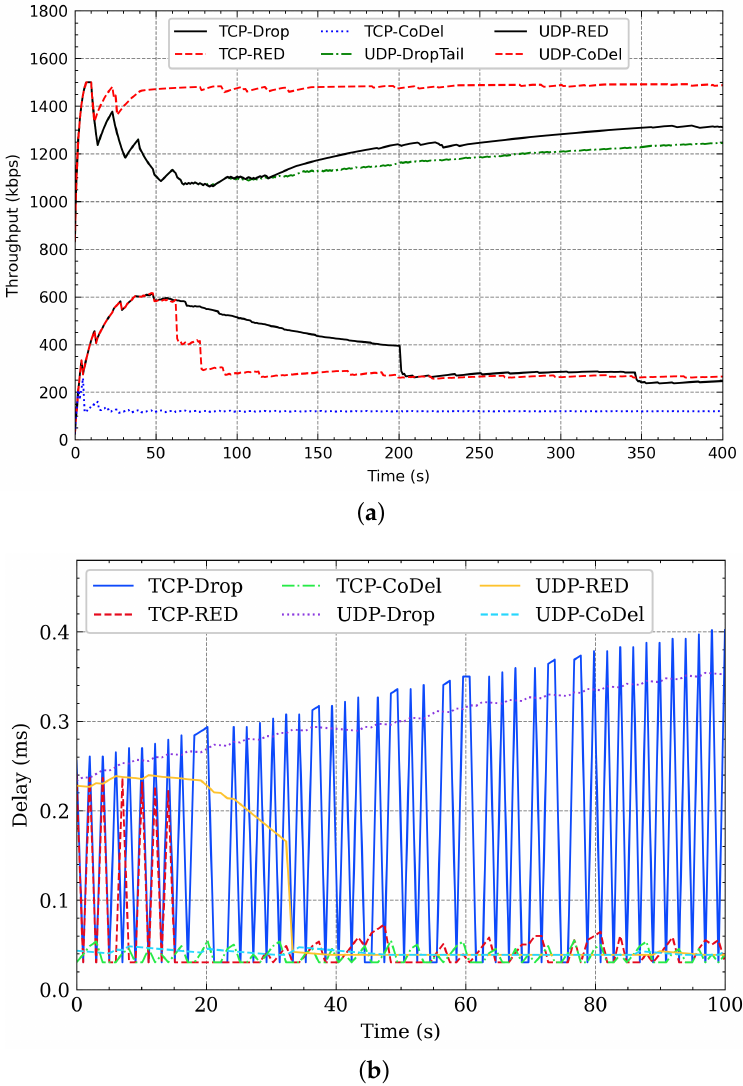
Figure 3. TCP and UDP coexist. ( a ) The throughput when TCP and UDP coexist. ( b ) The delay when TCP and UDP